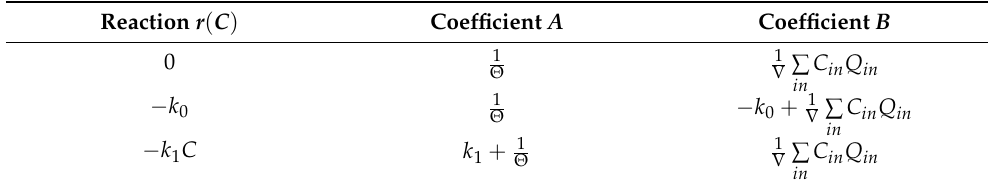
Table 4. Coefficients A and B in the linear differential Equation (22) for each reaction case. Reaction r ( C